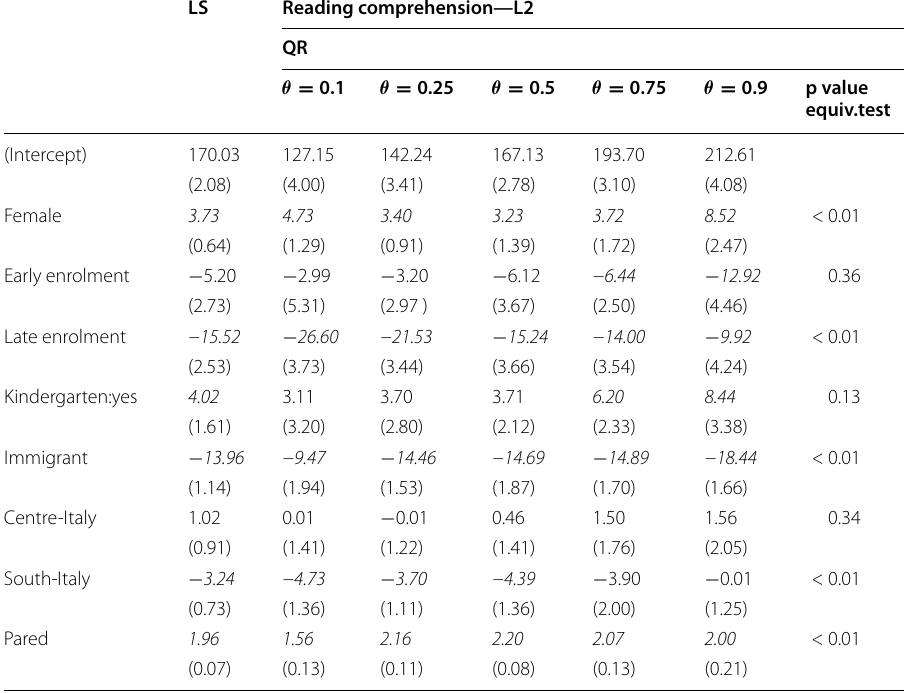
Table 2 LS and QR estimates of the effects of covariate on reading comprehension in pri- mary school—second